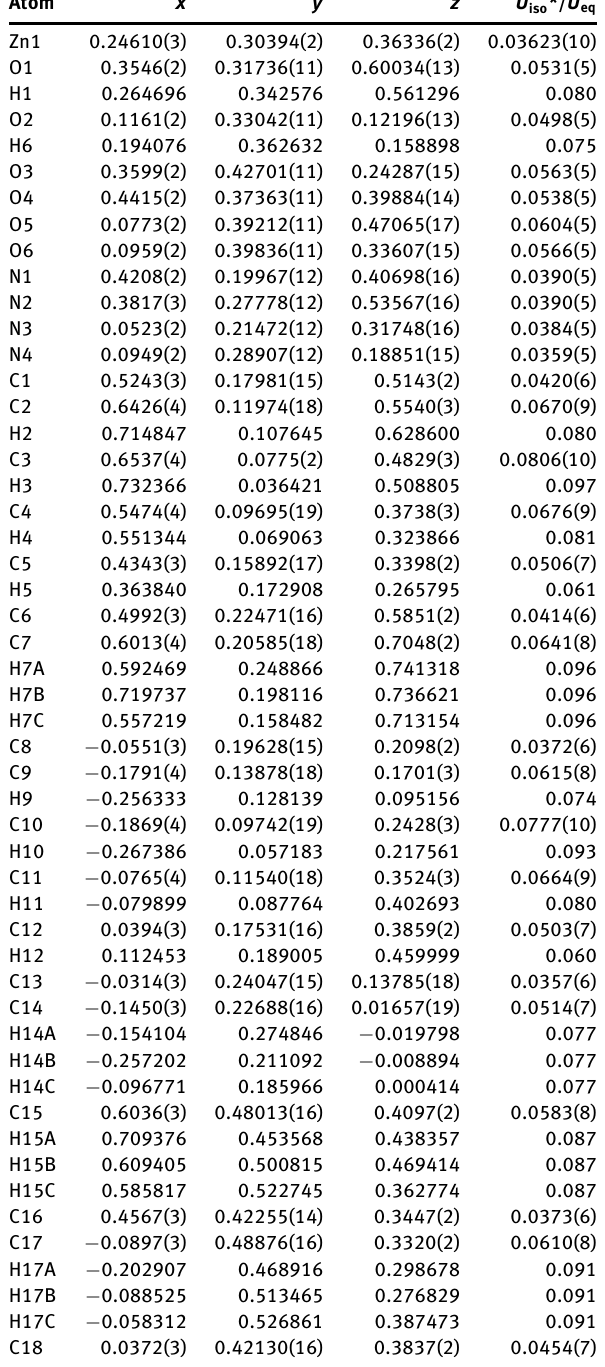
Table 2: Fractional atomic coordinates and isotropic or equivalent isotropic displacement parameters (Å 2